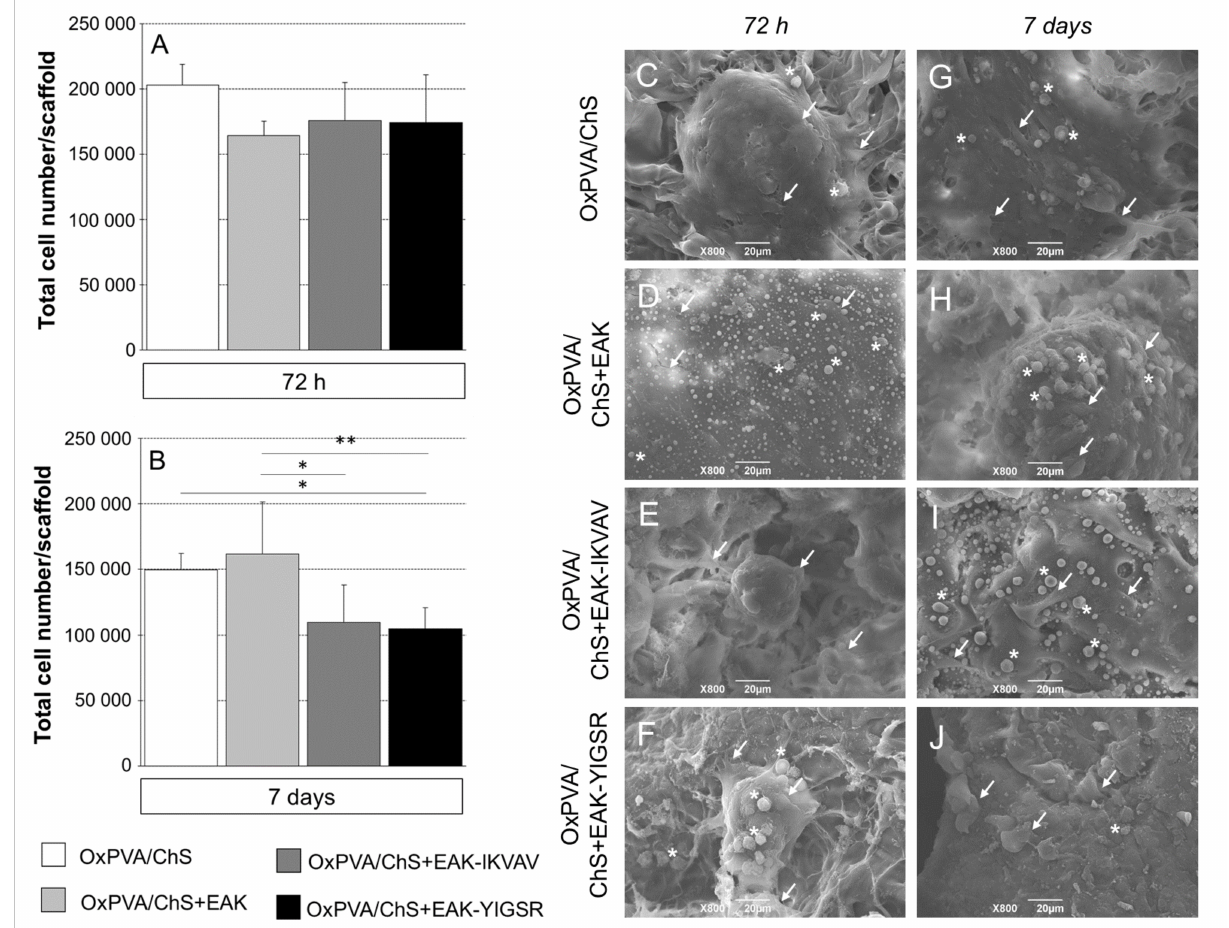
Figure 3. ( A , B ) SH-SY5Y cell adhesion and proliferation on different OxPVA/ChS-based scaffolds, evaluated by MTT assay. Bioactivation occurred through the incorporation of biochemical stimuli (+EAK, +EAK-IKVAV, and +EAK-YIGSR) within the chitosan layer. ( A ) At 72 h from seeding, no statistically significant difference in cell adhesion was observed comparing groups. Differences in proliferation were detected since day 7. ( B ) The higher total cells number was displayed by OxPVA/ChS+EAK scaffolds, while the lower cells number was observed on OxPVA/ChS+EAK- YIGSR scaffolds (* p < 0.05; ** p < 0.01). ( C – J ) OxPVA/ChS-based scaffolds surface analysed by SEM at 72 h ( C – F ) and 7 days ( G – J ) from SH-SY5Y cell seeding. Specifically, the experimental groups included: OxPVA/ChS ( C , G ); OxPVA/ChS+EAK ( D , H ); OxPVA/ChS+EAK-IKVAV ( E , I ); and OxPVA/ChS+EAK-YIGSR scaffolds ( F , J ). Scaffolds surface ultrastructure was not distinguishable once colonized by cells (white arrows). Representative clumps with roundish cells are shown (white asterisk). Scale bar: 20 µ